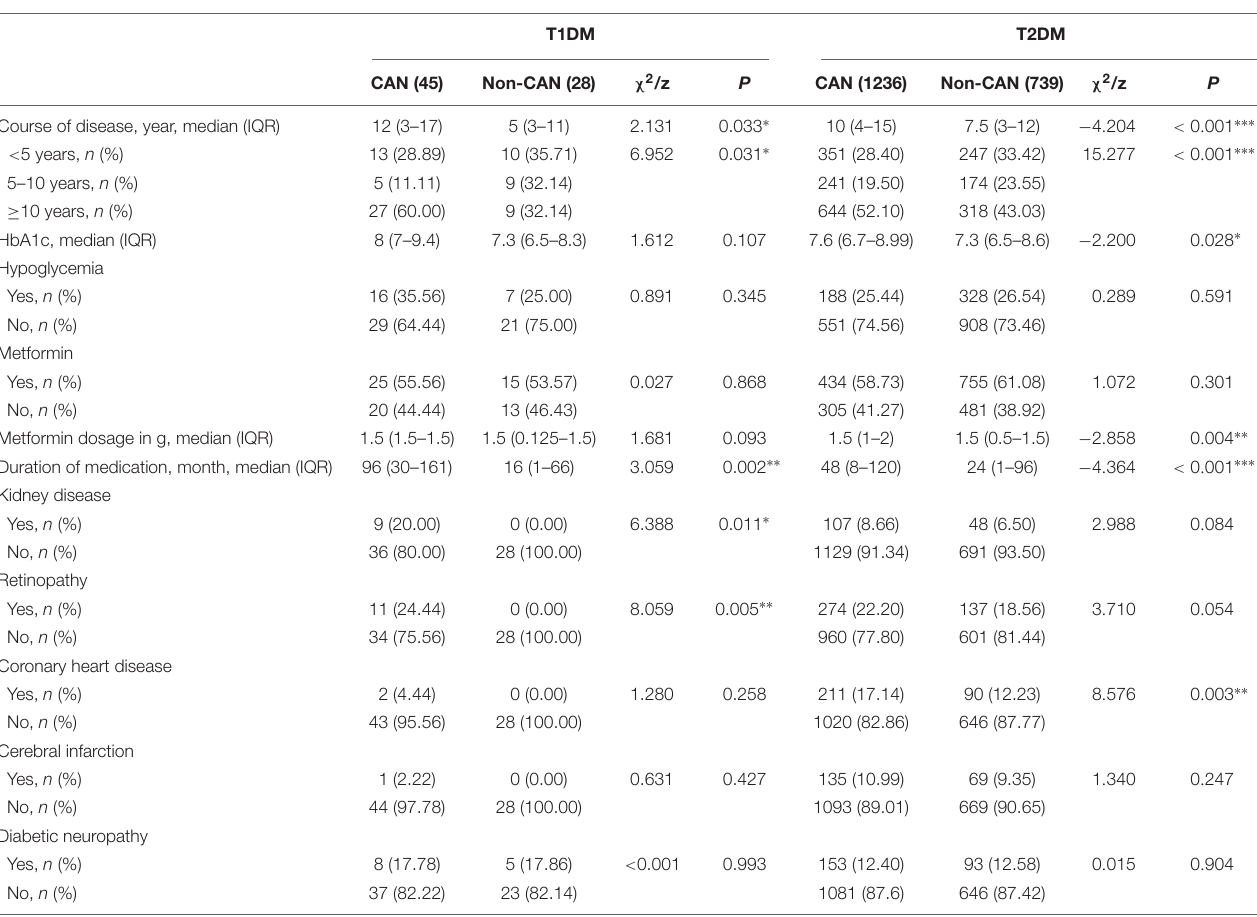
TABLE 2 | Patient history and complications of T1DM and T2DM groups by CAN